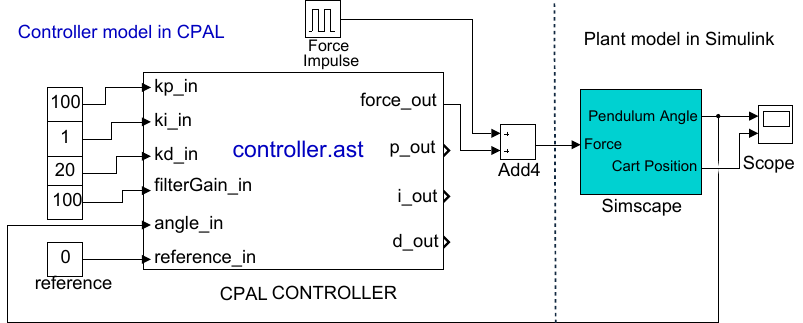
Figure 4. Controller model for an inverted pendulum integrated within the Simulink environment. Input data of the controller are visible in the design window and can be changed without the need to access the CPAL model. The output data are updated by the CPAL controler. The controller model is written in CPAL and executed by an interpreter embedded in the controller block. The ast file format is the more-compact binary equivalent form of the source-code controller